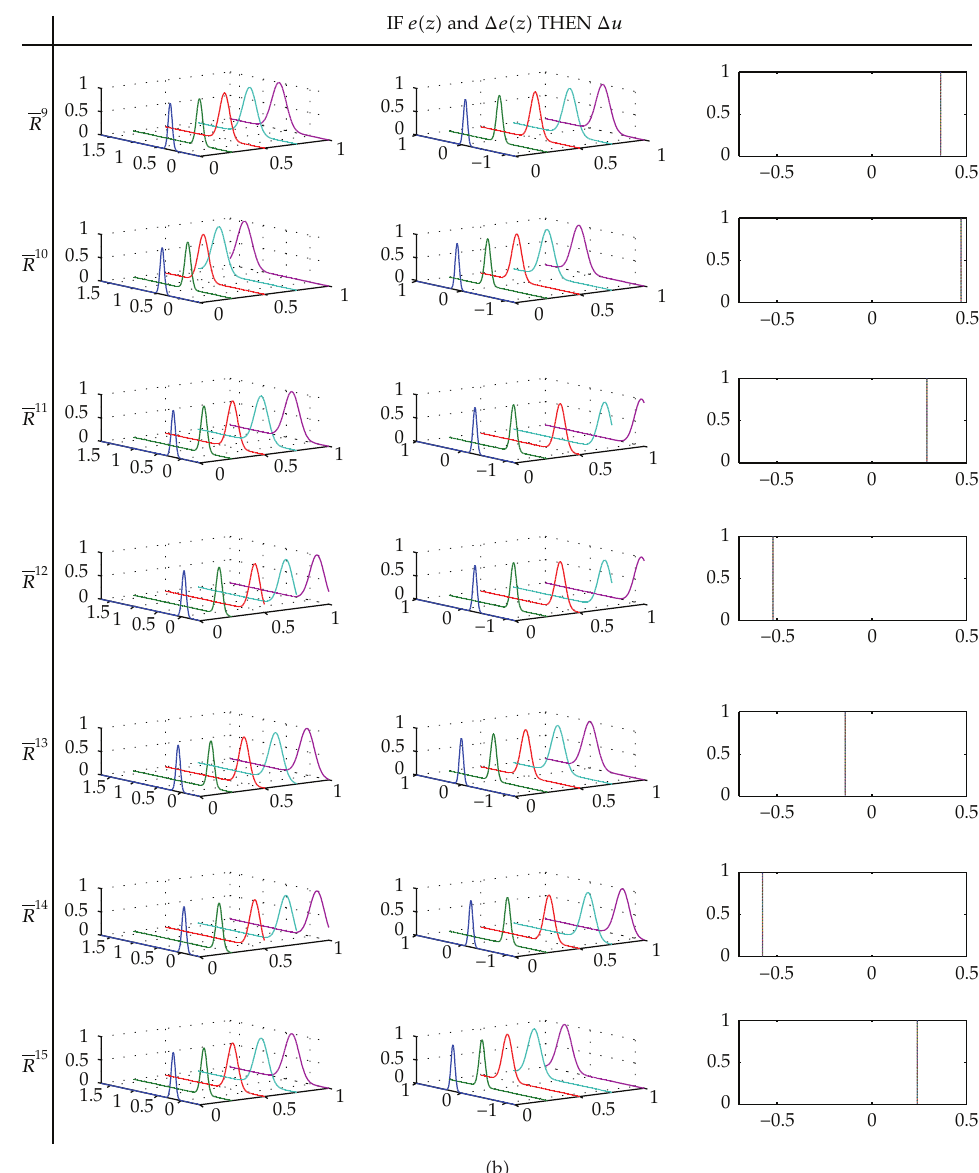
Figure 6: 3-D fuzzy rules and their associated 3-D fuzzy sets of a clustering and SVM-regression learning- based 3-D